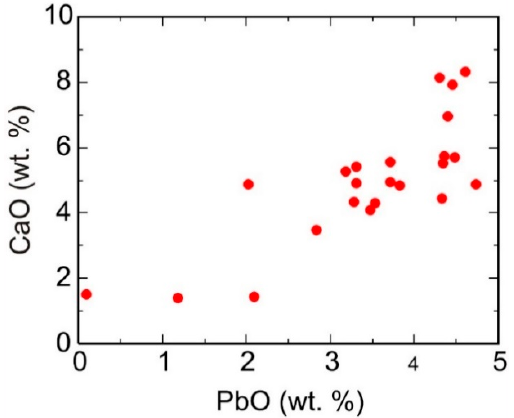
Figure 13. Distribution of Ca and Pb in uraninite from the Horní Slavkov uranium district.